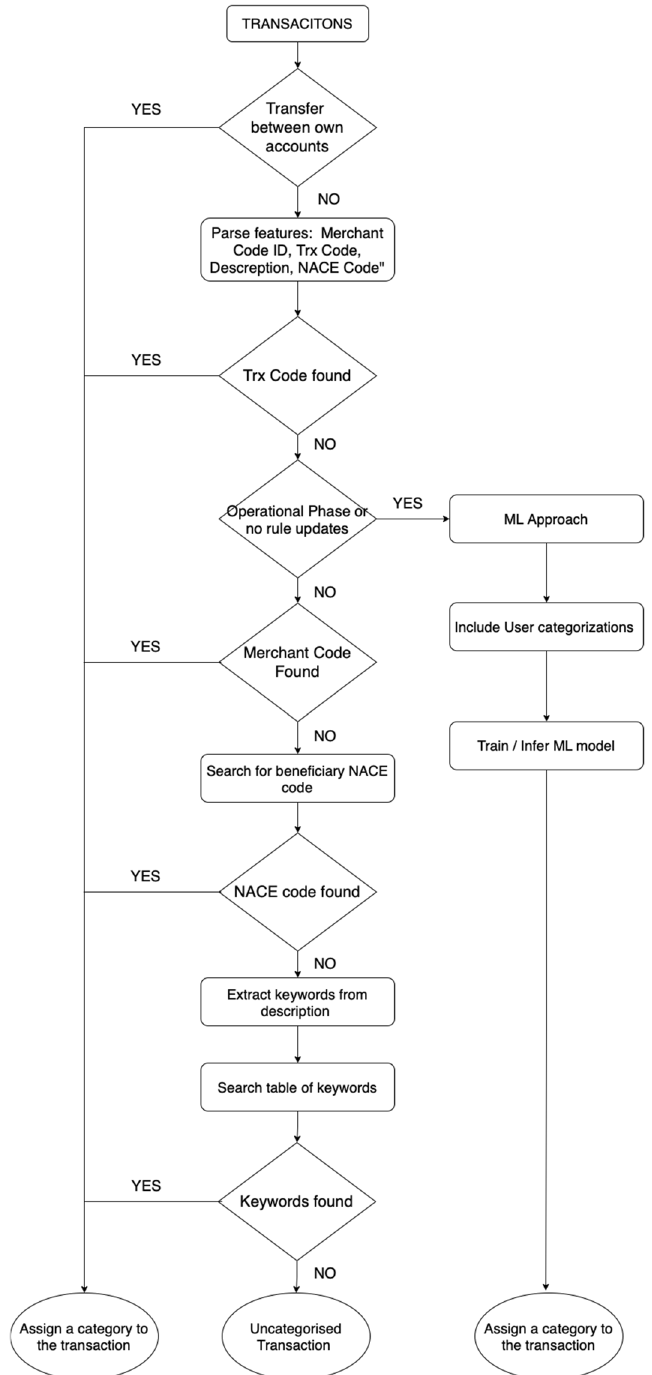
Fig. 6 Hybrid classification model